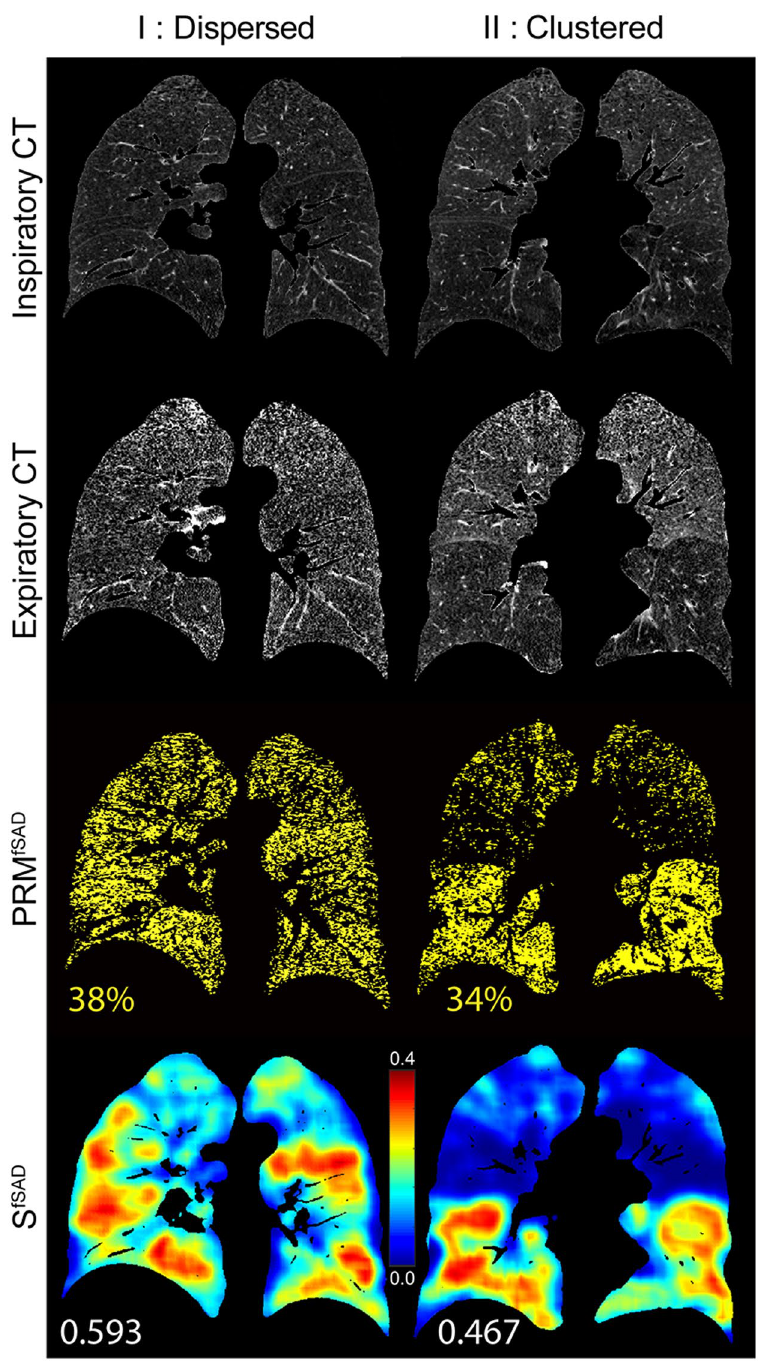
Figure 2. Two cases are presented with varying topological PRM features. Both cases have near-identical spirometry readouts and PRM fSAD relative volumes yet display differing fSAD topological features: dispersed disease (I, left column) and clustered disease (II, right column). A representative slice is shown for each case for the respective (top to bottom) inspiratory CT, expiratory CT, PRM fSAD map, and Local S fSAD map (multiplied by Local V fSAD in order to emphasize regions of substantial disease). PRM fSAD relative volumes and Local S fSAD values are displayed for